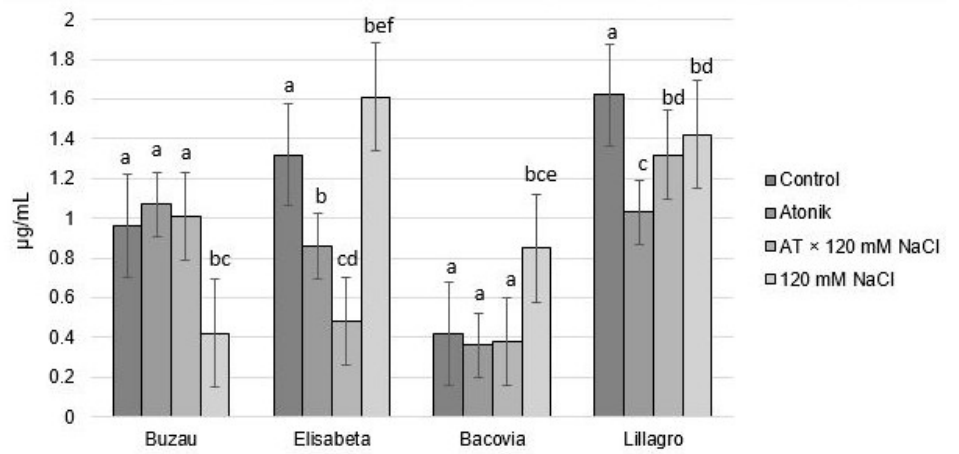
Figure 9. The effect of Atonik biostimulants on the concentration of carotenoids under saline stress after the third treatment. Different letters mean significant differences, according to the Tukey test. Error bars indicate ±SD.